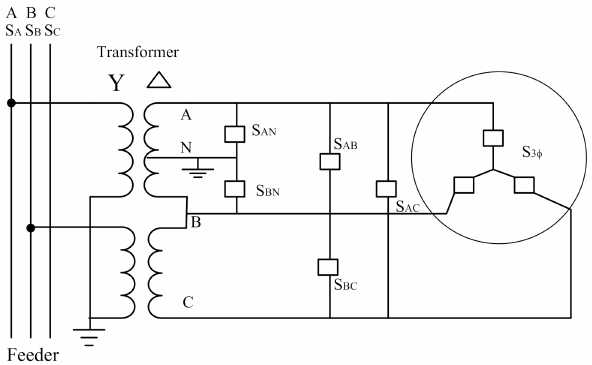
Figure 1. The loads of the open-wye / open-delta transformer.